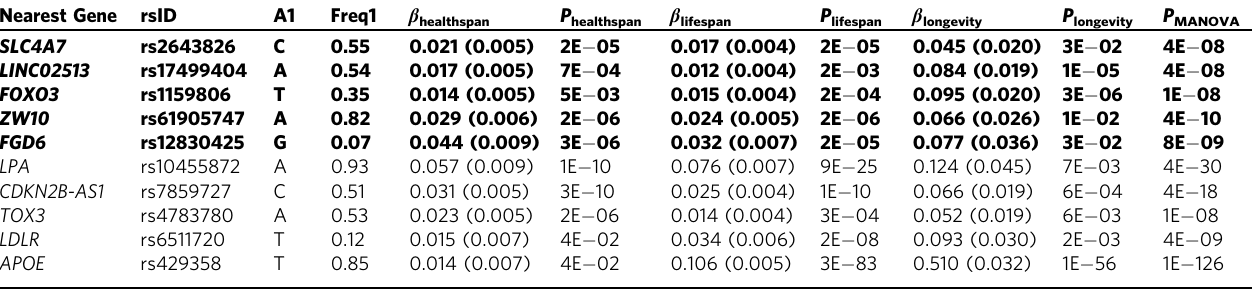
Table 1 Ten loci act across all three ageing traits, reaching nominal signi fi cance in each dataset. Nearest Gene rsID A1